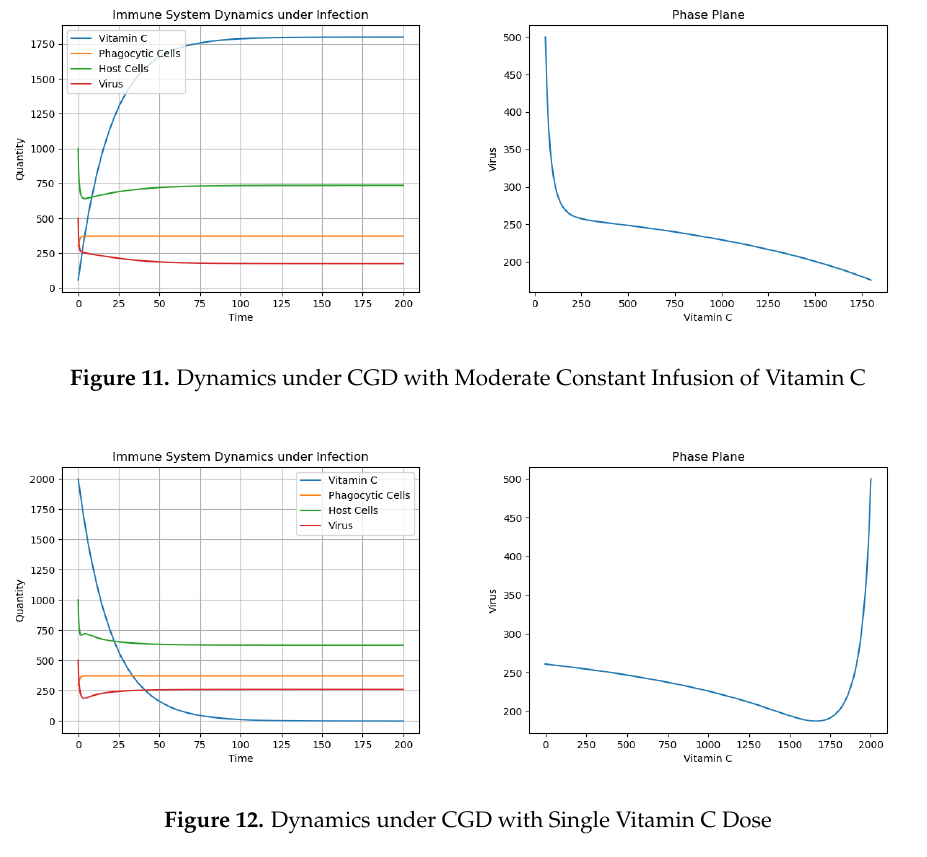
Figure 12. Dynamics under CGD with Single Vitamin C